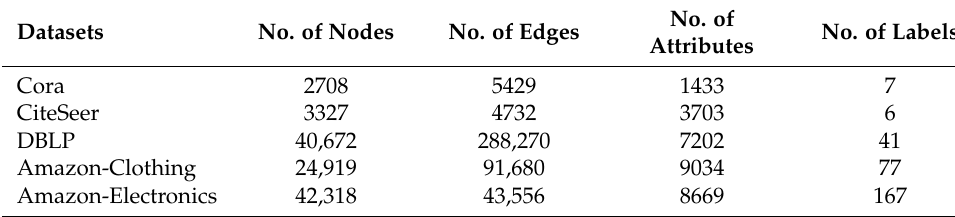
Table 1. Statistics of